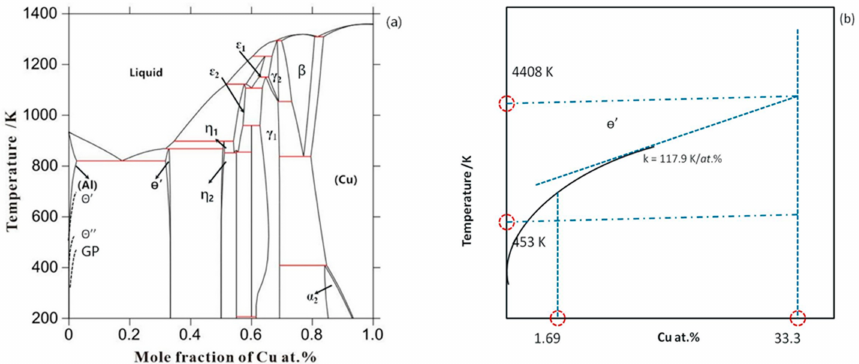
Figure 2. ( a ) Calculated Al-Cu phase diagram based on TCAL5 by means of Thermal-Calc [53]; and ( b ) schematic illustration of the linearization of FCC phase boundary in the phase diagram [55].